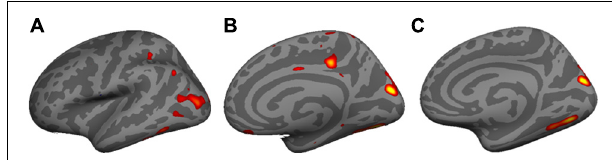
FIGURE 6 | Vertex-wide cortical thickness analysis showed an association with (A) pregnenolone in the left lateral occipto-temporal cortex, and (B) with allopregnanolone in the right medial occipital cortex and (C) right inferior medial temporo-occipital cortex (Cluster Forming Threshold (CFT) p < 0.01;